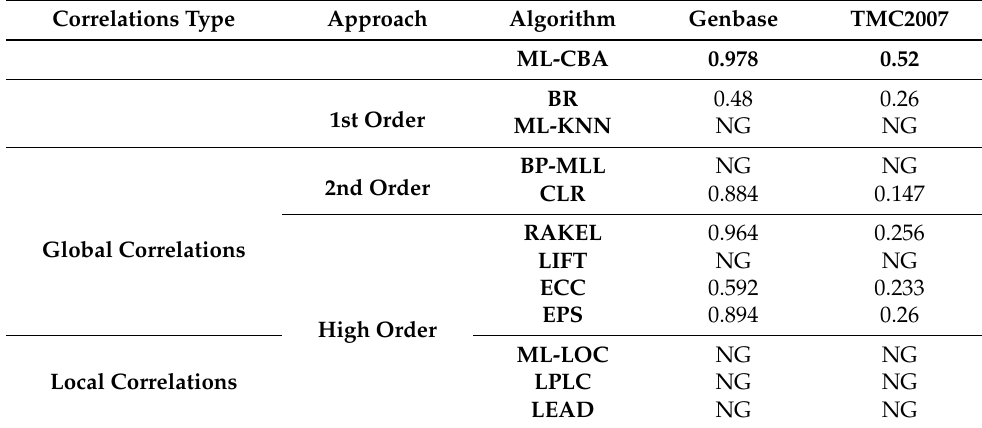
Table 8. The exact match results of the proposed ML-CBA algorithm on the large-sized datasets with respect to several other MLC algorithms.